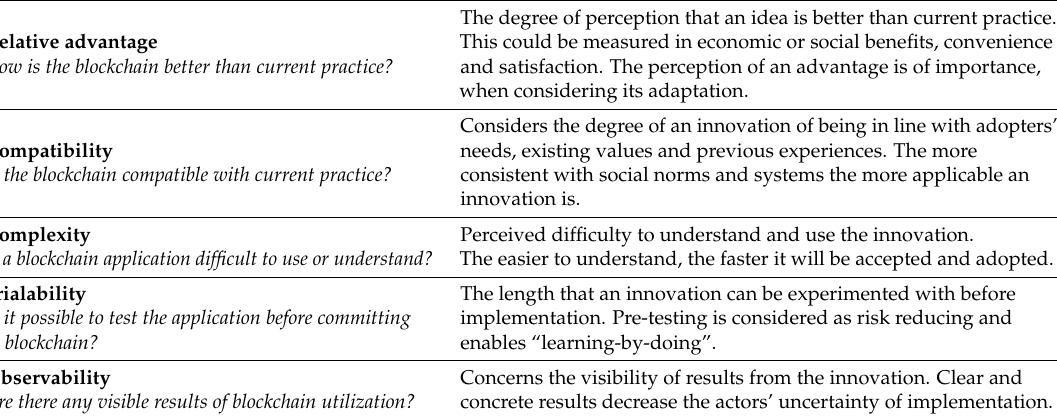
Table 2. Attributes of